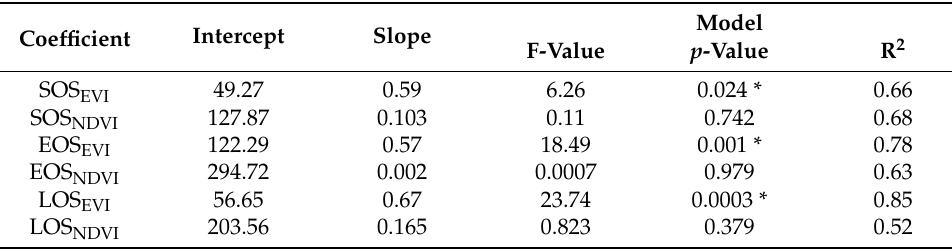
Table 2. Linear mixed model effect of GCC on the vegetation indices (NDVI and EVI) for onset (SOS), ending (EOS), and length of growing season (LOS). Significance level was at * = p < 0.05.